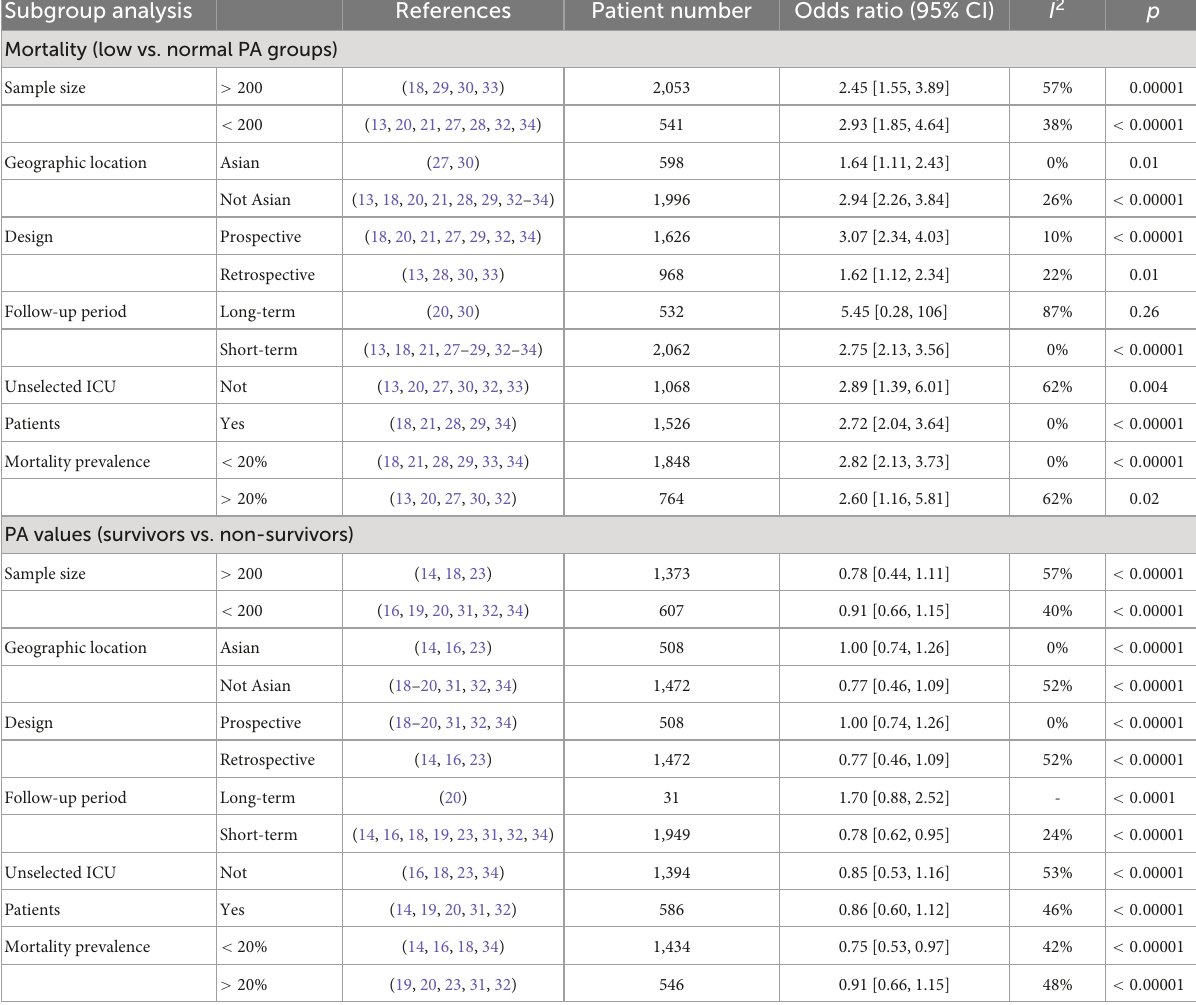
TABLE 3 Subgroup analysis on association between phase angle (PA) and mortality in critically ill patients. Subgroup analysis